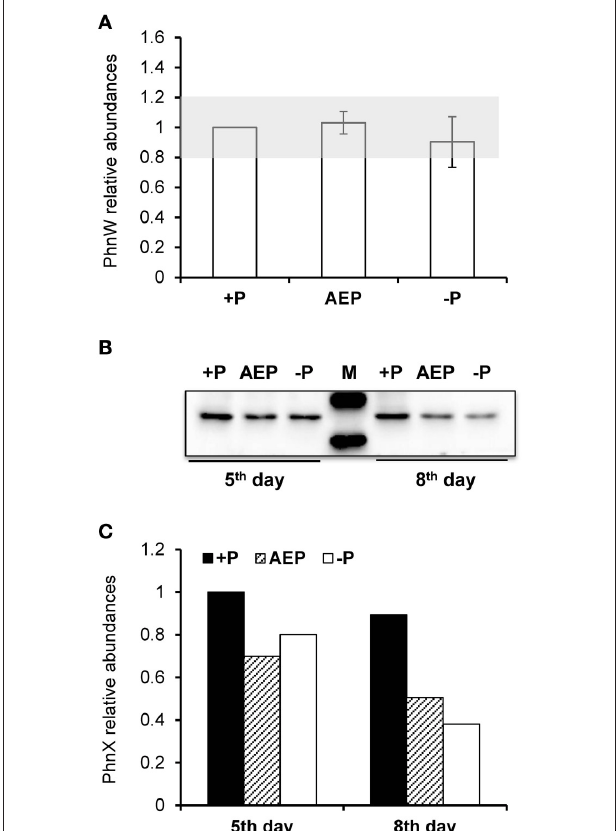
FIGURE 2 | Protein abundances of PhnW and PhnX in K. veneficum grown under different P conditions. (A) Relative abundances of PhnW quantified from iTRAQ analysis using the control culture ( Gray shading depicts the range within which the fold changes relative to the control are considered as insignificant. (B) Western blot showing abundances of PhnX protein under different P conditions. (C) Relative abundances of PhnX quantified from the western blot using the control culture ( reference. P, P-replete condition; AEP, P-depleted condition amended with + 2-AEP; P, P-depleted −